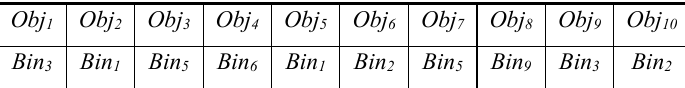
Fig. 1. Solution Representation